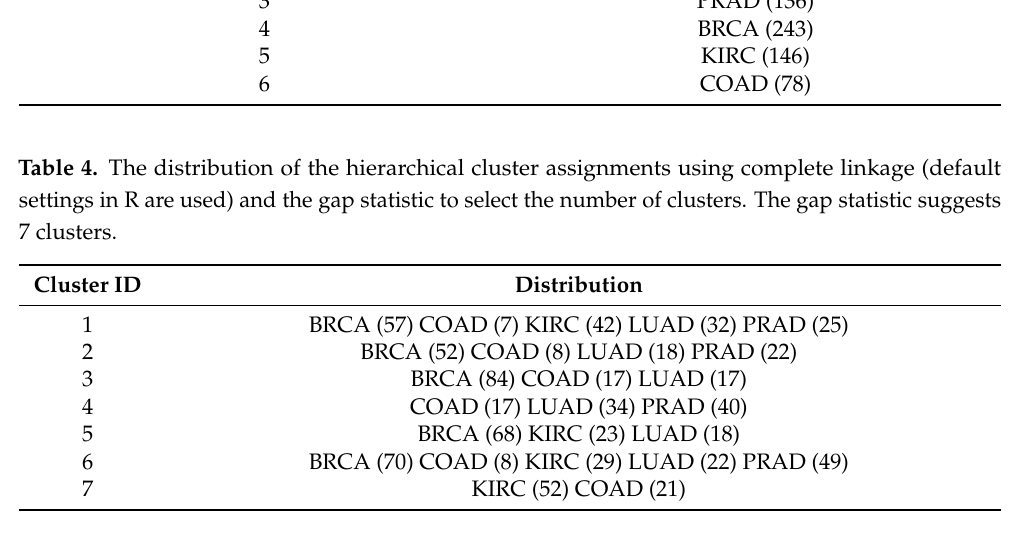
Table 5. The distribution of the hierarchical cluster assignments using single linkage (default settings in R are used) and the gap statistic to select the number of clusters. The gap statistic suggests exactly 1